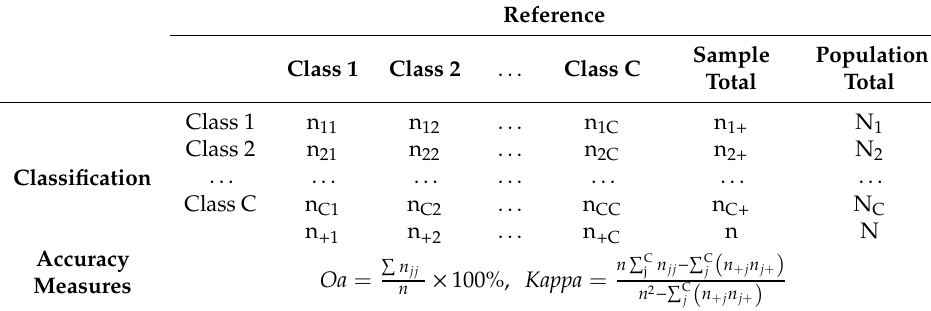
Table 1. Error matrix for thematic accuracy